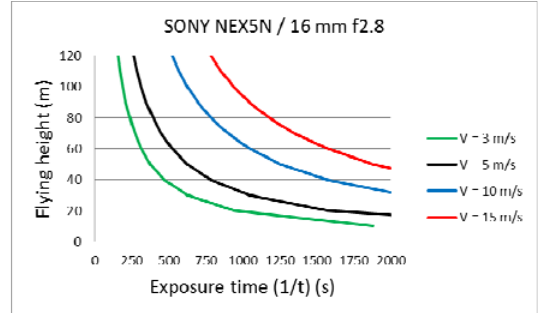
Figure 8. Acceptable exposure times for different flying heights above terrain at given UAS speeds to keep motion error at 0.5 pixels for the Sony NEX